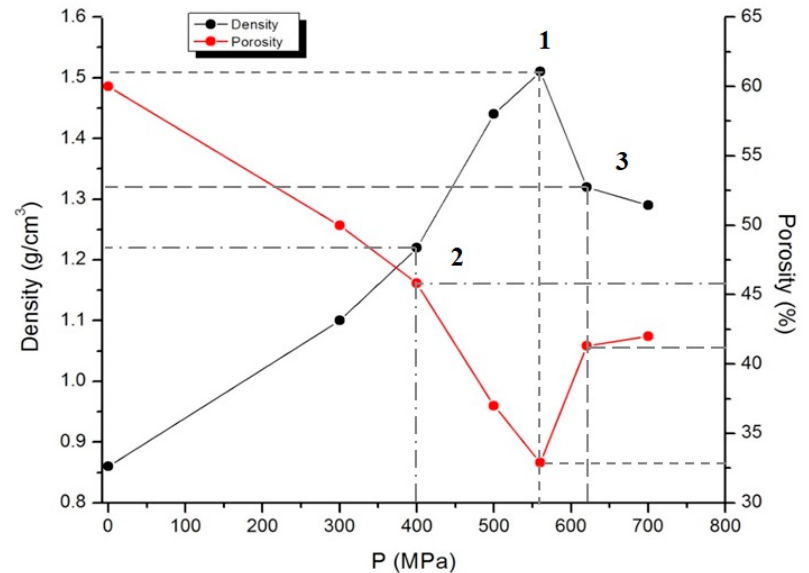
Figure 4. Density and porosity-pressure diagram for samples 1–3.